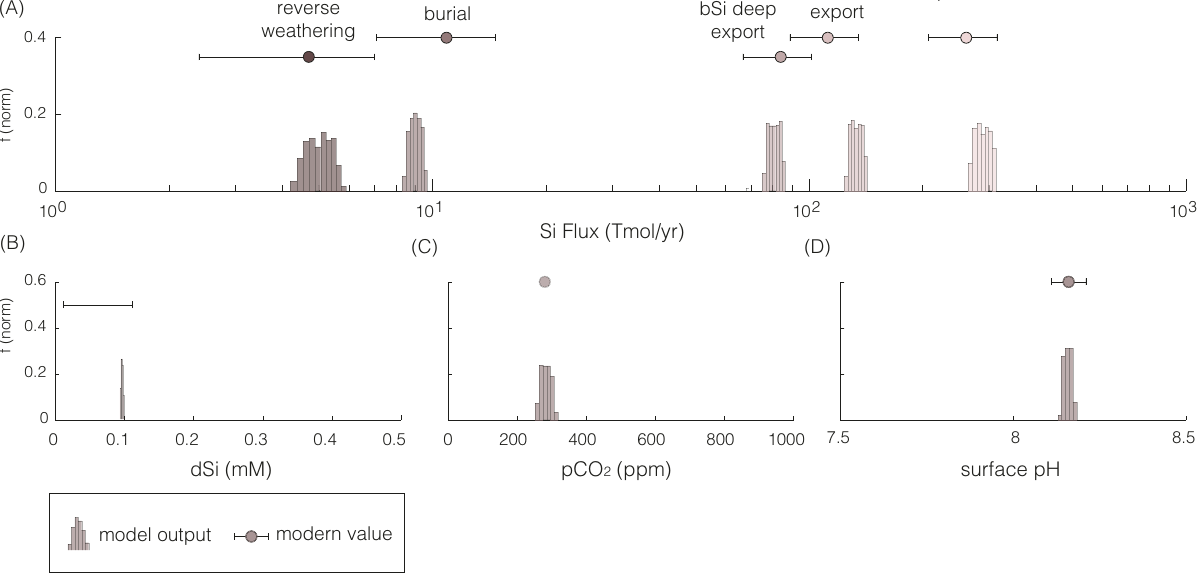
= 140, r = 3, r = 1, and Alk:Si = 0.3. Vertical si H 2